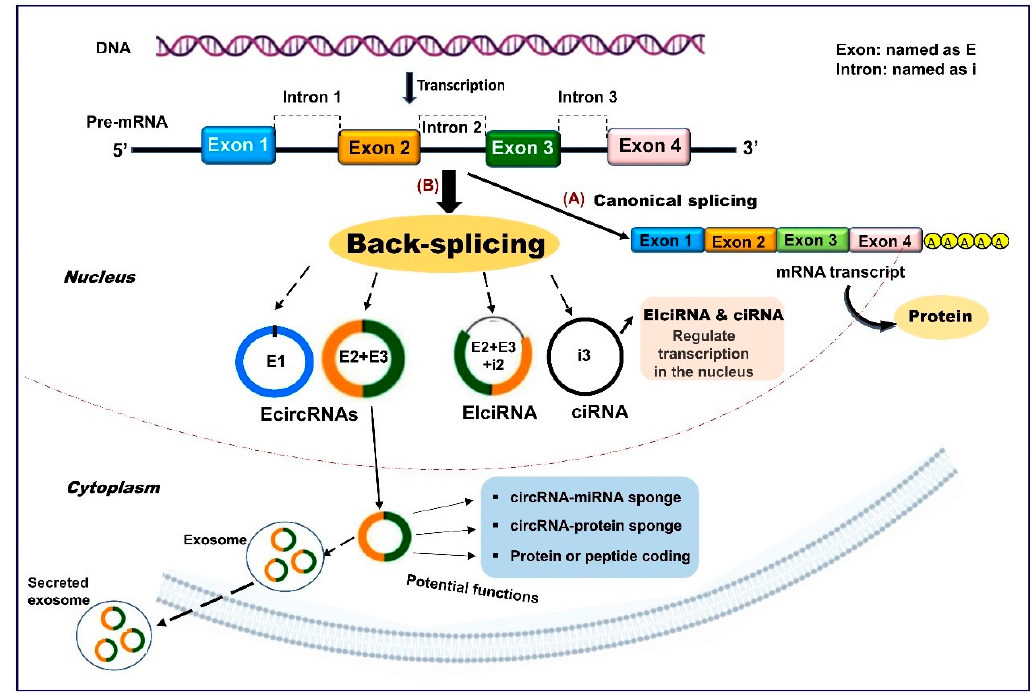
Figure 1. A simplified schematic representation of circular RNAs (circRNAs) biogenesis. ( A ) Pre-mRNA can undergo canonical splicing to generate a linear mRNA transcript that is subsequently translated into protein. ( B ) Pre-mRNA can also be spliced in the noncanonical manner “back-splicing”, wherein a downstream splice donor site is joined to an upstream splice acceptor site to produce circular RNA molecules. Three di ff erent types of circRNAs can arise from di ff erent genomic positions and combinations, including: ( 1 ) exonic circRNAs (EcircRNAs), ( 2 ) exon-intron circRNAs (EIciRNAs), and ( 3 ) circular intronic RNAs (ciRNAs). The formation mechanisms and potential functions of these circRNA types are discussed in the text.